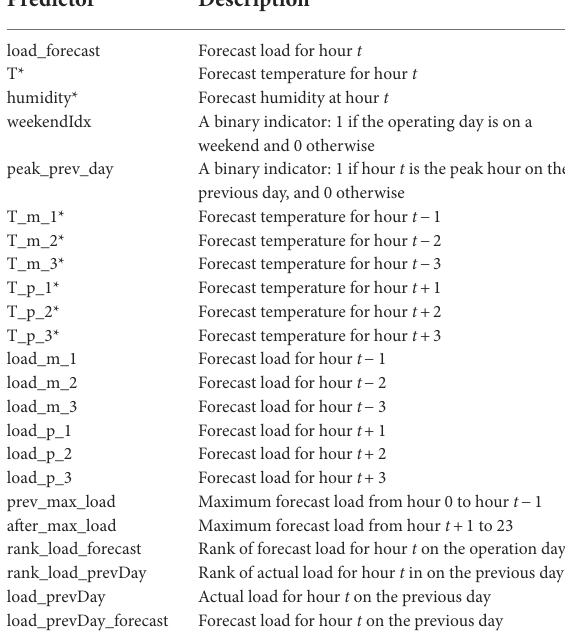
TABLE 3 Predictors for the peak hour